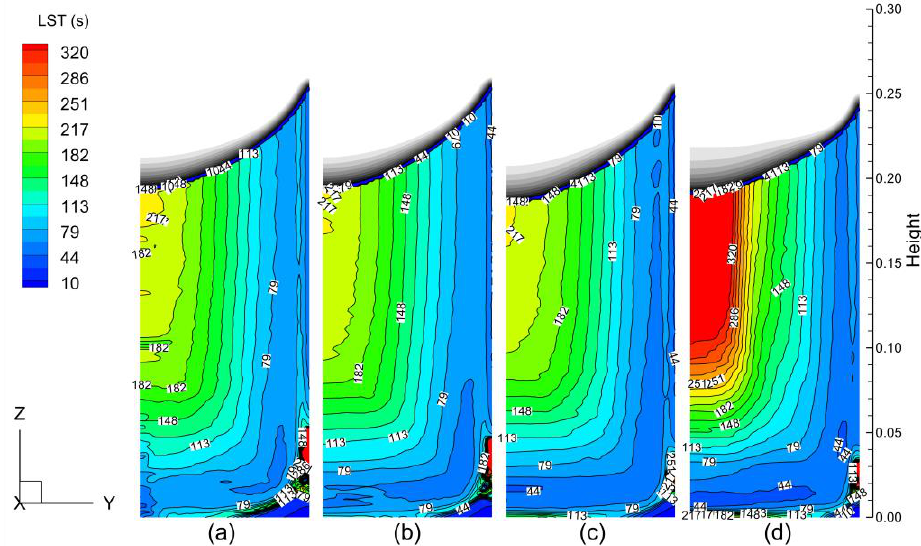
Figure 9. Predicted distributions of LST in the solidified ingot with the electrode rotating at different speeds: ( a ) 0; ( b ) 20 rpm; ( c ) 40 rpm; ( d ) 60 rpm.